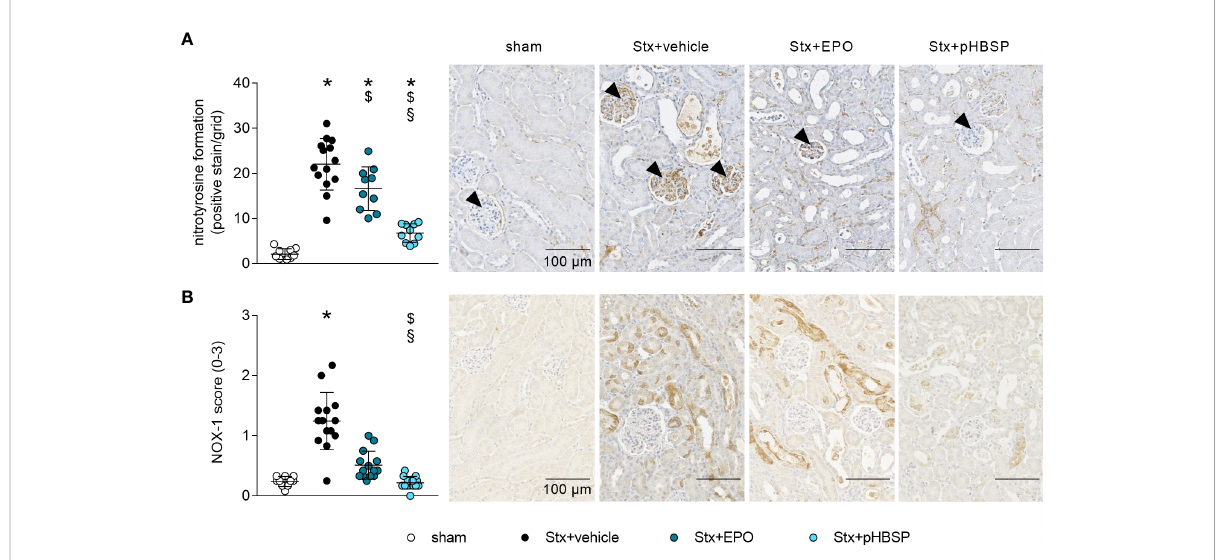
FIGURE 7 Effectsof EPO andpHBSP treatmenton nitrosativeandoxidative stressinmicewith HUS. Nitrosativeandoxidativestresswereassessedon day7ofHUS experiment. Quanti fi cationdataandrepresentativeimagesof immunohistochemical stainingof (A) nitrotyrosine(shamn=10, Stx+vehiclen=14, Stx+EPO n =10, Stx+pHBSPn=10, arrowheadsindicatingglomeruli)and (B) NOX-1(shamn=10,Stx+vehicle n=14,Stx+EPOn =14, Stx+pHBSPn =14)inkidney sectionsofshammice andStx-challengedmice. Quantitativedataareexpressedasscatterdotplotwithmean±SD.*P< 0.05vs. sham, $ P< 0.05 vs. Stx+vehicle, § P< 0.05vs. Stx+EPO(A:one-way ANOVA, Holm-Sidak ’ smultiplecomparisontest, B:Kruskal-Wallistest, Dunn ’ smultiplecomparisontest), scalebar100µm.